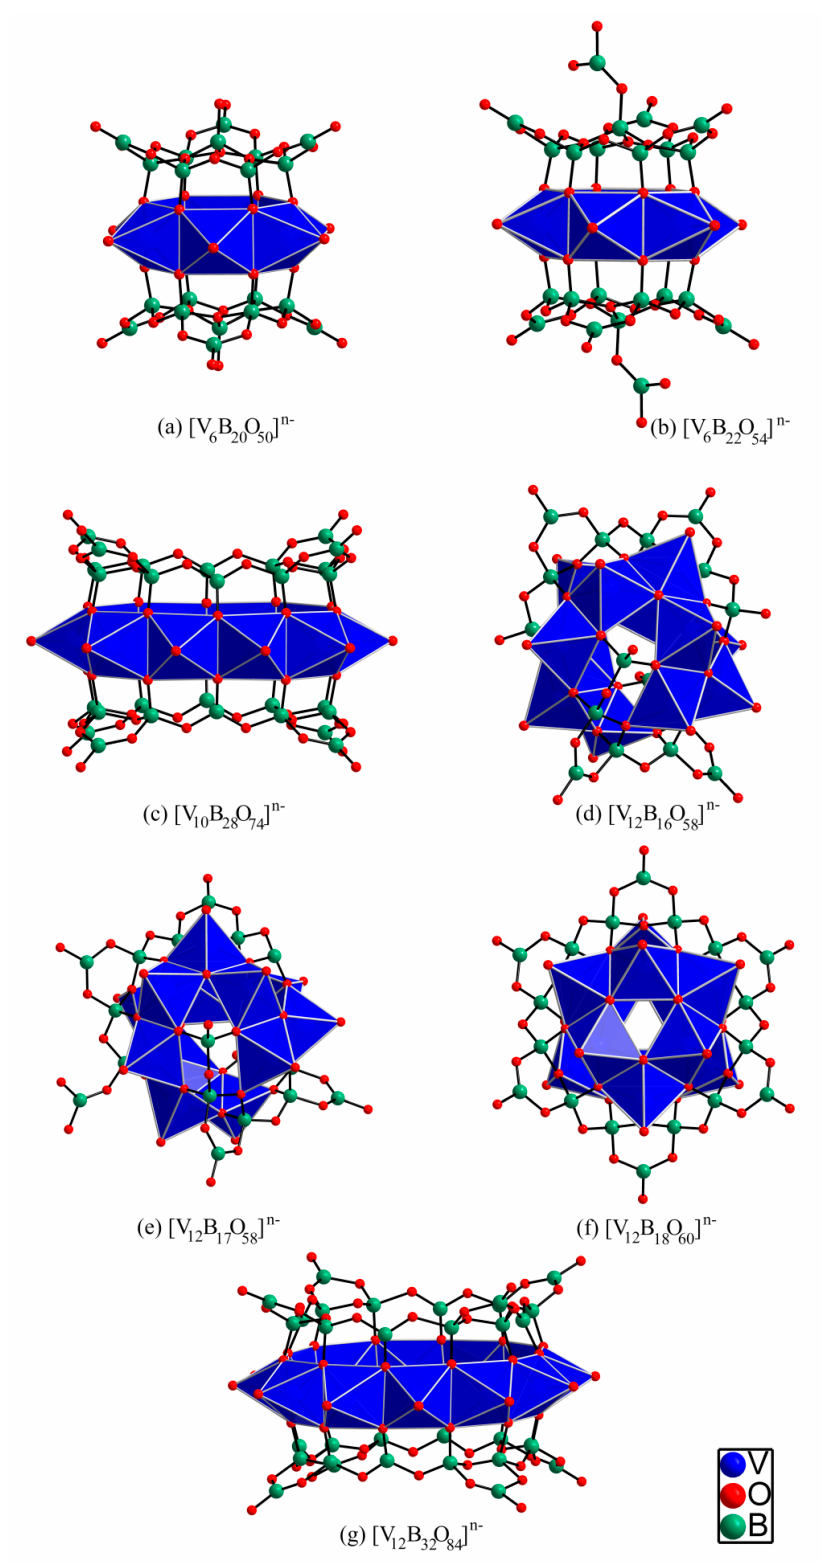
Figure 3. Structural representation of the different polyoxovanadoborate